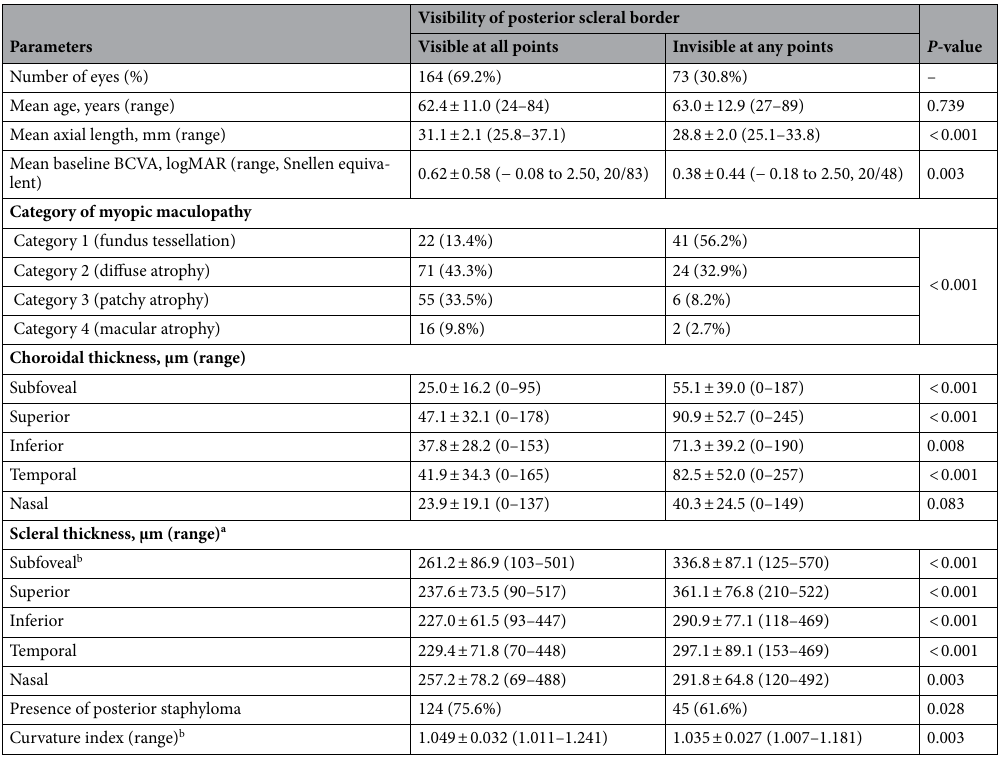
Table 2. Comparison of clinical characteristics according to the visibility of posterior scleral border. BCVA best-corrected visual acuity, logMAR logarithm of minimal angle of resolution. a Included only points where scleral thickness was measurable. b Excluded eyes with dome-shaped macula.